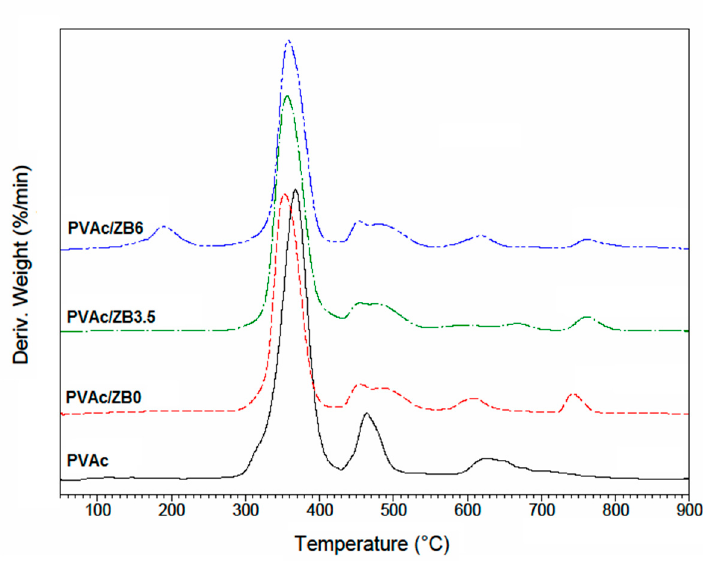
Figure 7. Thermogravimetric curves (the first derivative; DTG) for PVAc, PVAc / ZB0, PVAc / ZB3.5 and PVAc / ZB6.